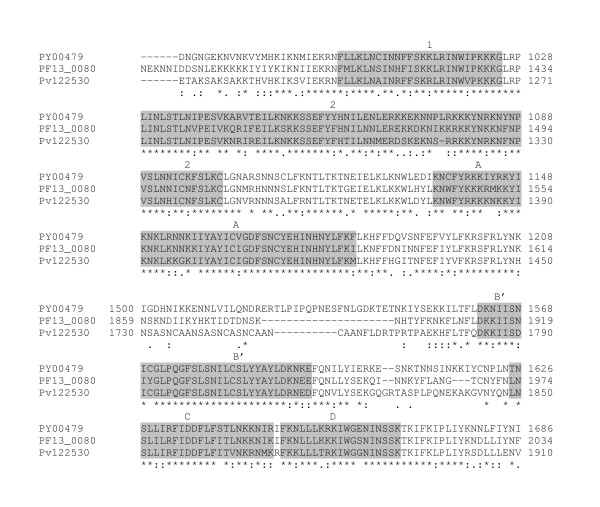
Multiple sequence alignment of PyTERT, PfTERT and PvTERT. Evidence for the putative P. y. yoelii (PY00479) and P. falciparum (PF13_0080) TERTs has been published previously [10-12]. The candidate P. vivax TERT (Pv122530) was identified in this study. Shaded blocks represent RT conserved domains. * residues common toall three sequences. : conserved residues. . semi-conserved residues